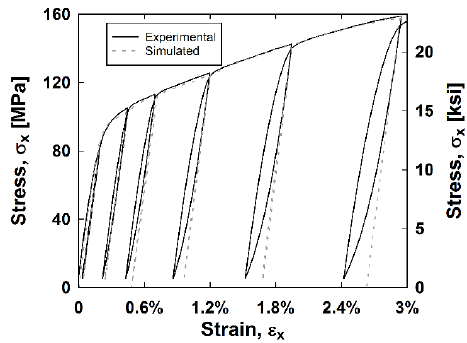
Figure 11. Stainless steel composite experimental and simulated stress – strain curve.